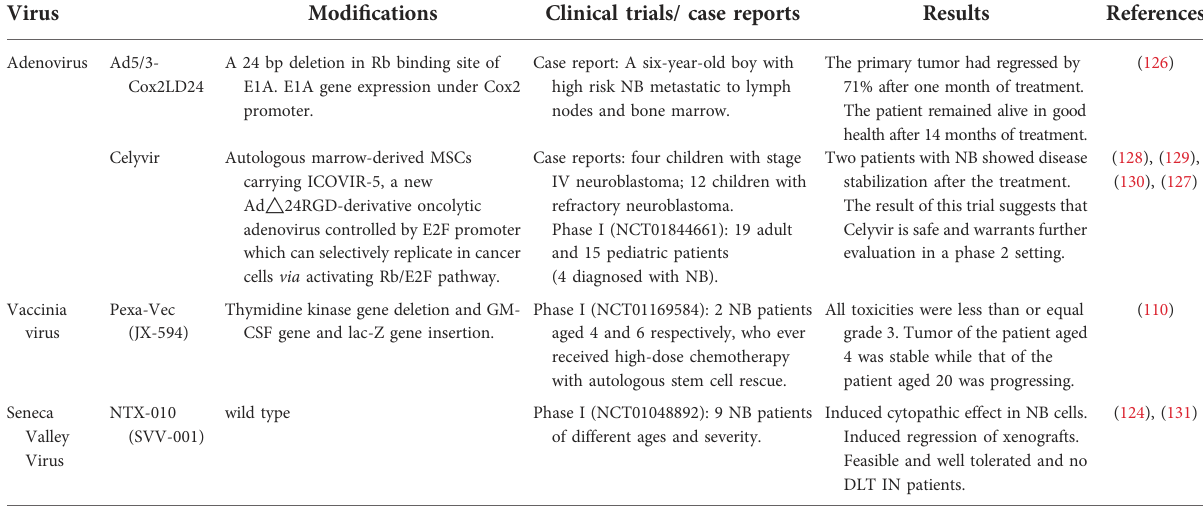
TABLE 2 Clinical trials/ case reports of oncolytic virotherapy for neuroblastoma. Virus Modi fi